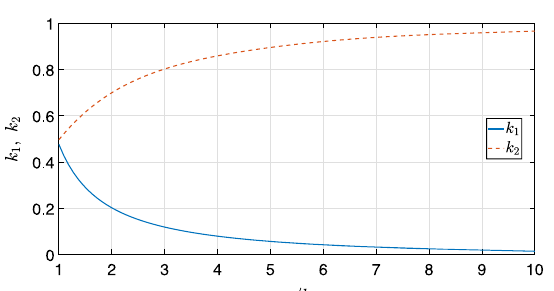
Fig. 7 Axial and lateral apparent-mass coefficients k 1 , k 2